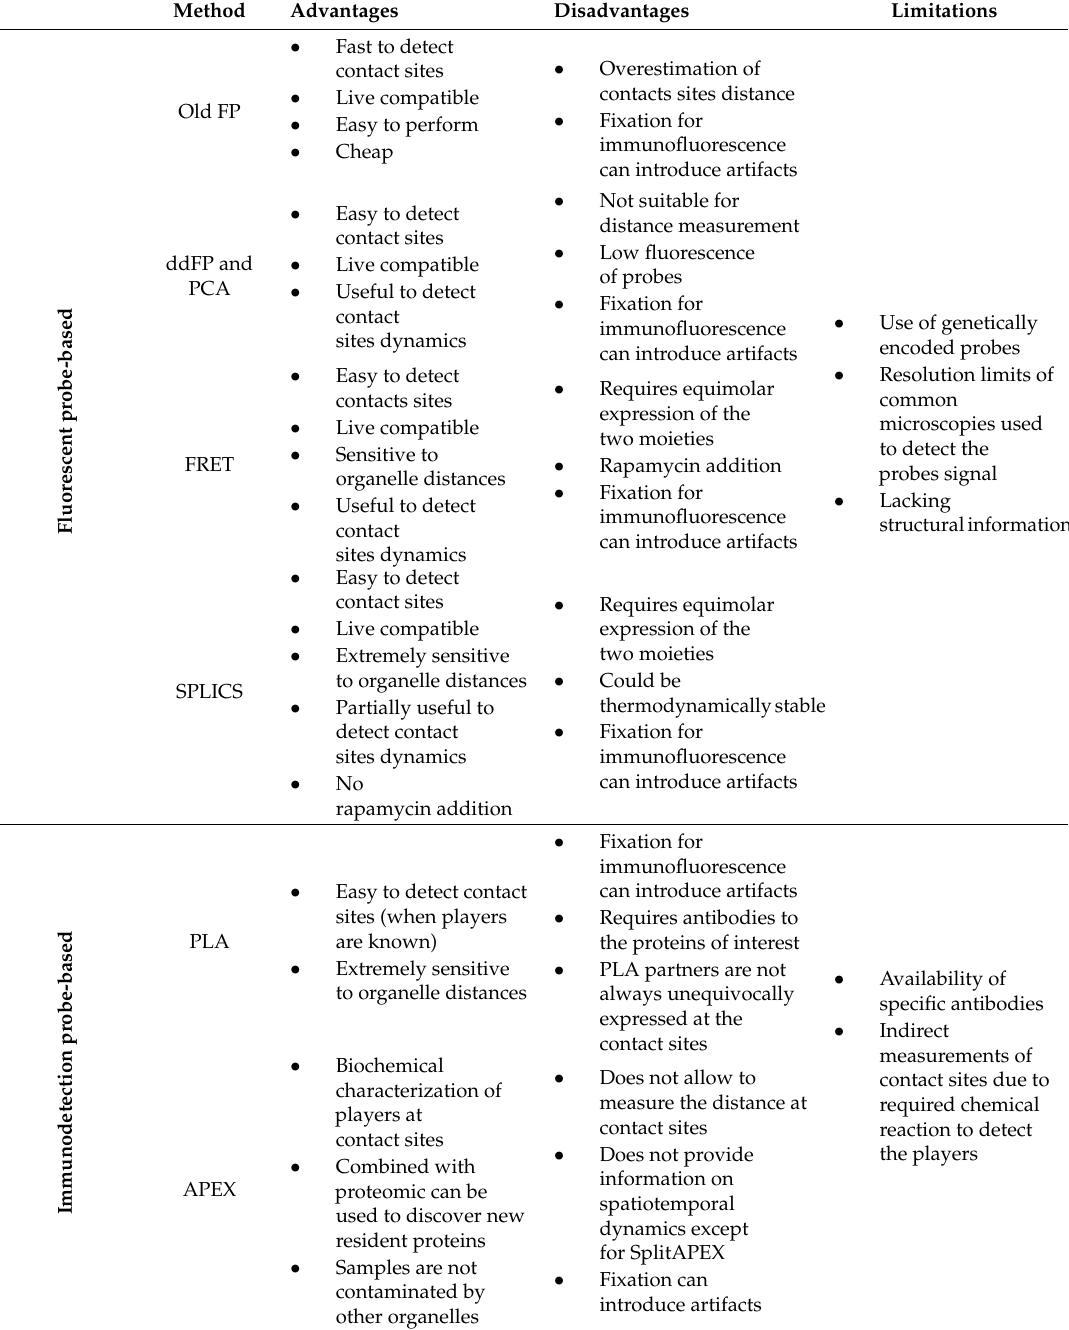
Table 1. Methods to assess ER–mitochondria contact sites and their advantages /